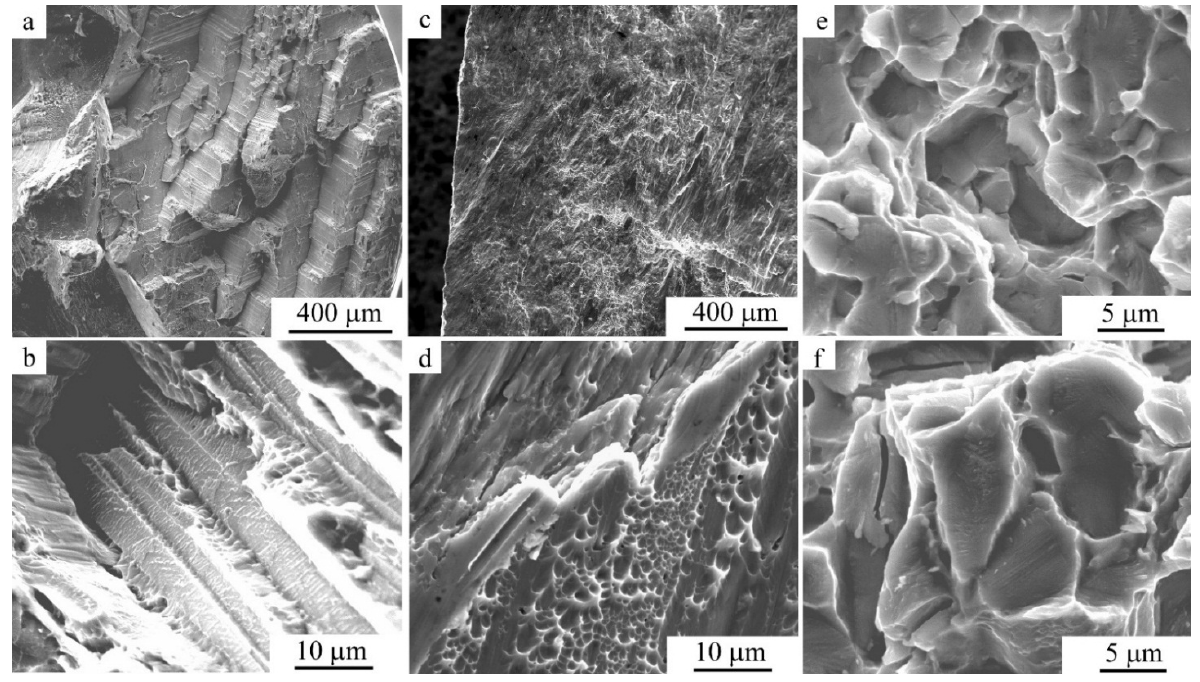
Figure 20. SEM images in SE mode of the fracture surfaces in the Cu-14Al-4Ni alloy after ( a – d ) ten- sile tests or ( e , f ) compression tests [47].